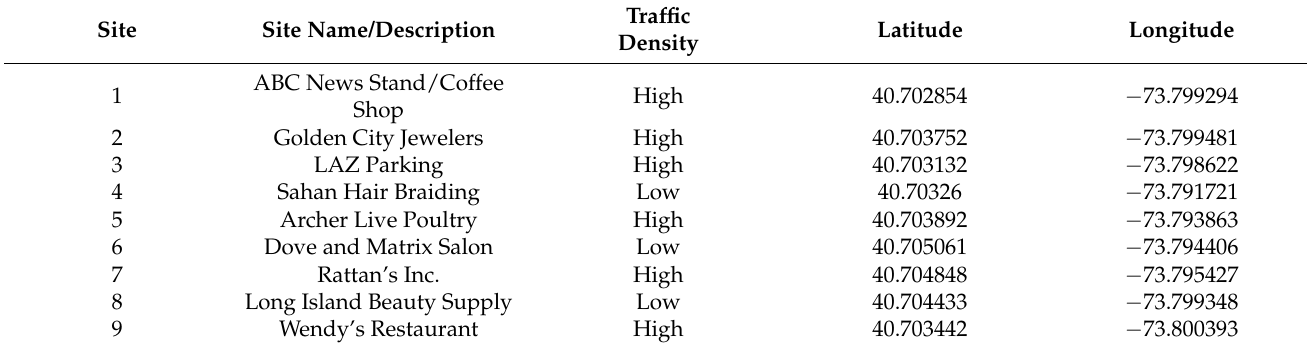
Table 1. Description of Sample Locations.